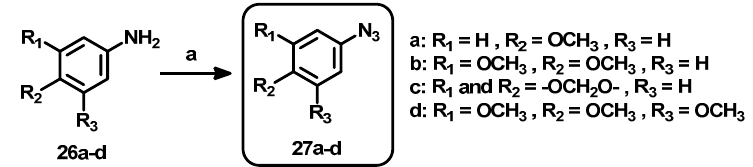
Molecules 2016 , 21 , 802 6 of 11 Figure 3. Structure of the neolignans veraguensin 1 , grandisin 2, and machilin G 3 . Figure 4. Structural design of 1,4-diaryl-1,2,3-triazole derivatives of the neolignans 1 – 3 . Triazole derivatives 4 – 19 were obtained via Click Chemistry strategy from 1,3-dipolar cycloaddition reactions between terminal acetylenes 25a – d and aromatic azides 27a – d with methoxy and methylenedioxy substitution patterns [12]. The synthesis of starting materials began by preparing aryl bromides 21a – c via a bromination reaction of 20a – c in the presence of NBS, p -TsOH, CH 2 Cl 2 and SiO 2 [12,27]. Subsequently, a cross-coupling Sonogashira reaction between bromobenzenes 21a – c and 2-methyl-3-butyn-2-ol in the presence of PdCl 2 (PPh 3 ) 2 /CuI, Et 3 N provided the acetylene alcohols 22a – c with 81%–86% yields, after 24 h reaction time [12,28]. Retro-Favorski reaction of 22a – c with KOH under reflux in toluene generated the terminal acetylenes 25a – c with 75% to 79% yield [12,28–30]. Ethynyl-1,2,3-trimethoxybenzene 25d was synthesized by the Corey-Fuchs method (Scheme 1) [12,31]. Scheme 1. Synthesis of aryl acetylenes 25a – d [12]. Reagents and reaction : (a) 20a – c (75 mmol), NBS (75 mmol), TsOH (10 mmol), SiO 2 (37 g), CH 2 Cl 2 (210 mL), room temperature, 3 h, 21a = 79%, 21b = 82%, 21c = 85%; (b) 21a – c (50 mmol), 2-methyl-3-butyn-2-ol (183 mmol), PdCl 2 (Ph 3 ) 2 (2.5 mmol), CuI (5 mmol), Et 3 N (250 mL), reflux, 24 h, 22a = 81%, 22b = 82%, 22c = 86%; (c) 22a – c (30 mmol), KOH